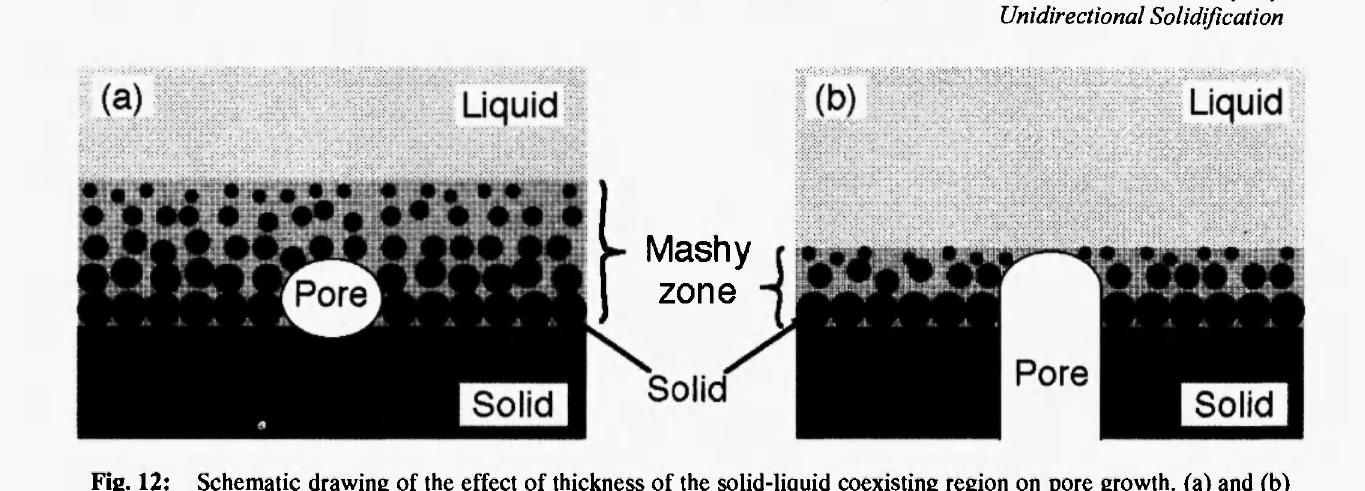
Fig. 12: Schematic drawing of the effect of thickness of the solid-liquid coexisting region on pore growth, (a) and (b) show the cases where the solid-liquid coexisting region is relatively thick and thin,